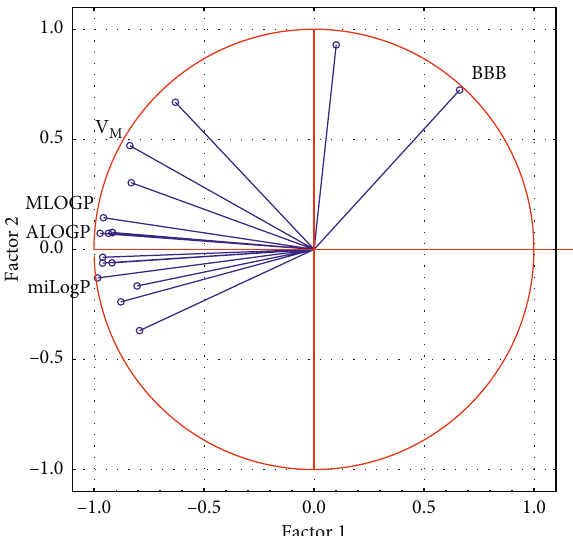
Figure 6: Projection of variables on the area of factors based on the first two